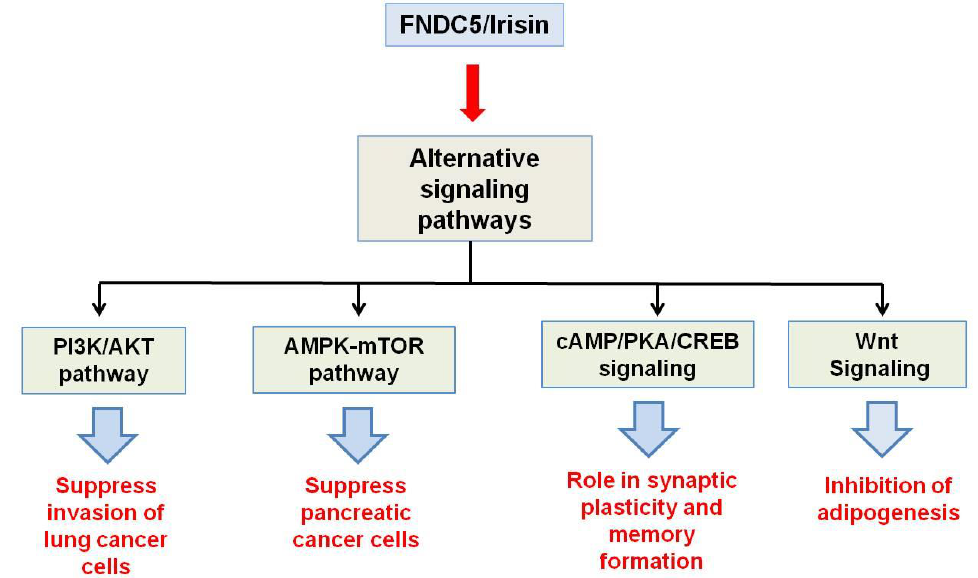
Figure 3. Schematic representation of physiological activities of Fndc5/irisin through pathways other than MAP Kinase signaling.